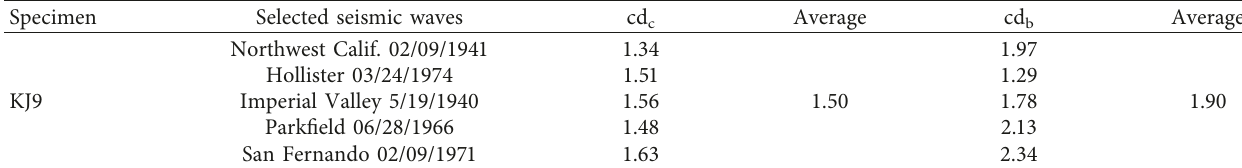
Table 27: Maximum curvature ductility coefficients of beams and columns in model KJ9.